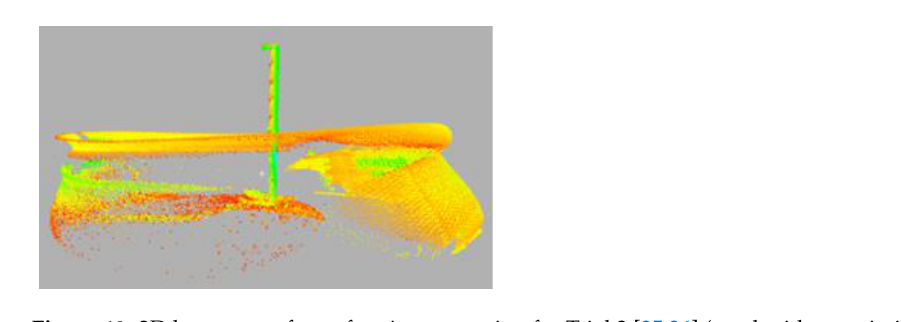
Figure 13. 3 D laser scan after refraction correction for Trial 2 [35,36] (used with permission).